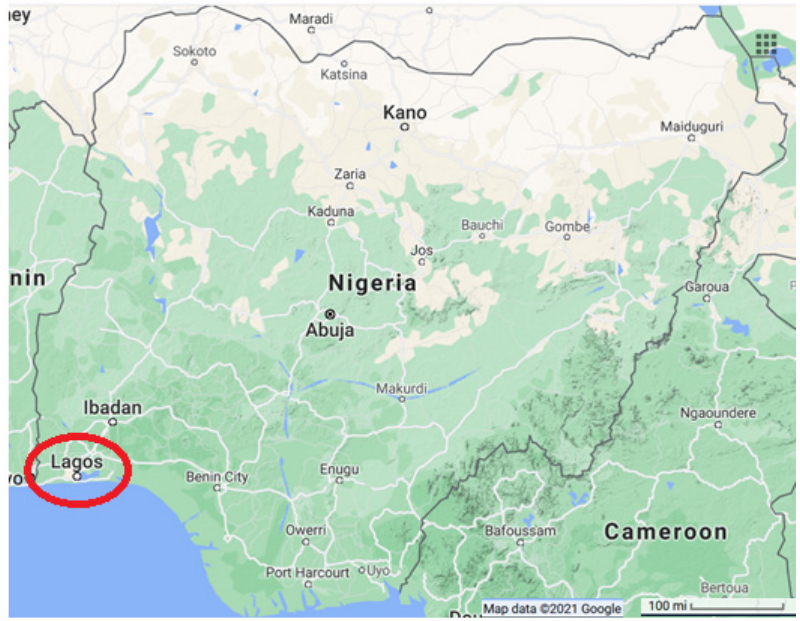
Figure 1. Lagos, highlighted, south of Nigeria in west Africa (Adapted from Google Maps (accessed on 24 August 2021)).